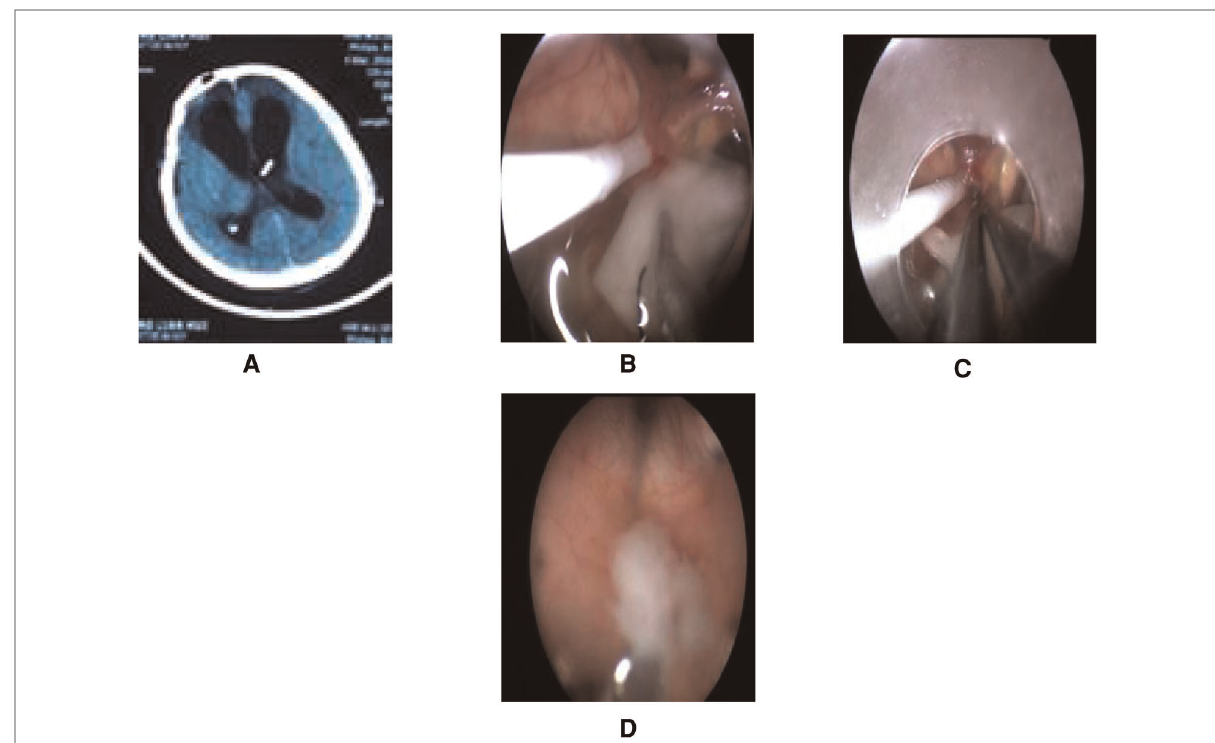
FIGURE 3 Endoscopic intraventricular surgery was performed to remove the VP shunt tube and to perform ETV in case 2. ( A ) Presurgical CT. ( B ) Surgical image showing intraoperative CSF turbidity, a shunt tube, and choroid plexus adherence. A patty was used to rapidly exchange the CSF with warm Ringer ’ s solution. ( C ) Surgical image showing bipolar coagulation of the choroid plexus vessels with a patty. ( D ) Surgical image showing the removal of purulent secretions at the Cerebral aqueduct of Sylvius by